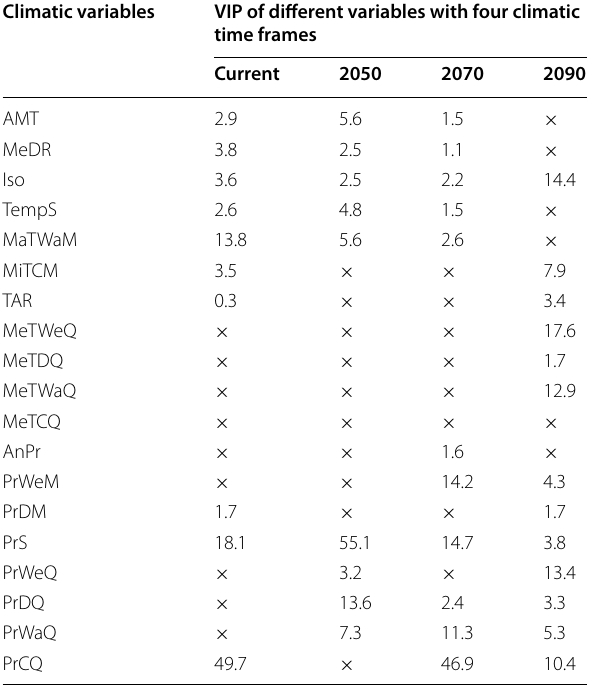
Bioclimatic variables with higher VIP values were then used as predictors alongside highly contributed non-bioclimatic variables to establish a link between species distribution and their environment : variables excluded due to their significant correlations with other variables ×